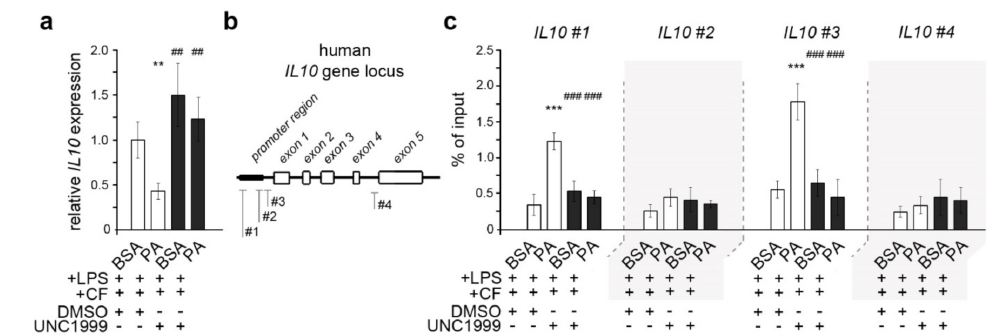
Figure 4. Palmitic acid exposure of dual-stressed HPdLFs resulted in decreased H3K27 trimethylation near IL10 promoter regions associated with decreased IL10 expression. ( a ) Quantitative expression analysis of IL10 in human periodontal ligament fibroblasts (HPdLFs) exposed to palmitic acid (PA) and simultaneously stimulated with compressive force (CF) and P. gingivalis LPS after treatment with 1.00 µ M UNC1999 compared to DMSO-treated BSA+LPS+CF control. ( b ) DNA primer locations in the IL10 gene locus indicating promoter-associated pairs (#1, #2 and #3) and a non-promoter-associated pair (#4). ( c ) Quantitative analysis of the associations of H3K27me3 with specific IL10 gene regions shown in ( b ) for dual-stimulated HPdLFs exposed to PA after UNC1999 treatment in comparison to the respective controls. Data were normalized to the sample input and IgG controls. **/## p < 0.01; ***/### p < 0.001; **/*** in relation to BSA+LPS+CF+DMSO; ##/### in relation to